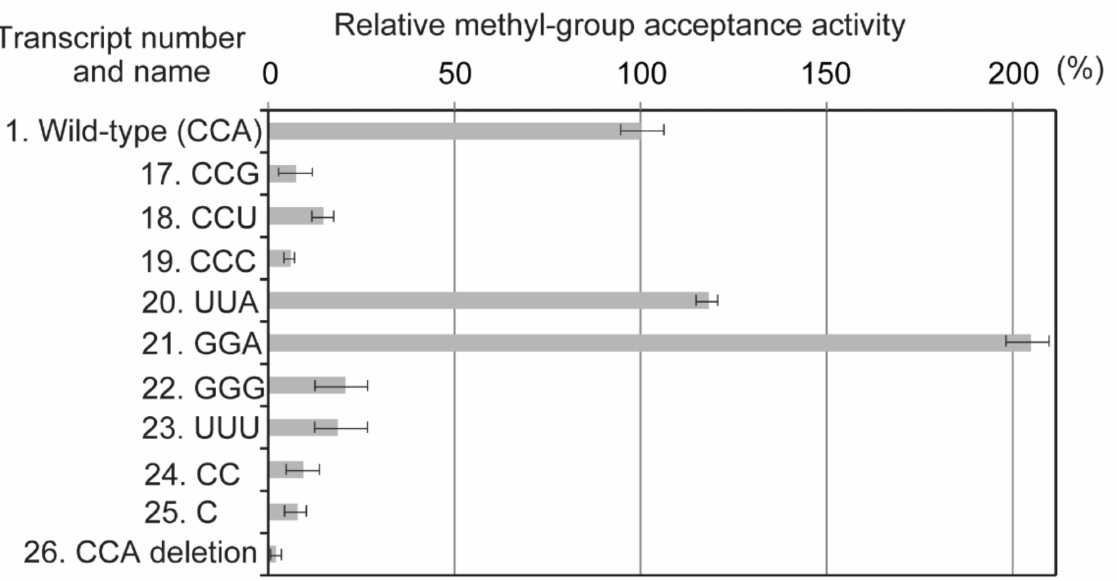
Figure 5. The CCA terminal region is essential for methylation by Trm11-Trm112. The CCA sequence of the wild-type tRNA Phe transcript was substituted by other sequences. For example, transcript 17 possesses CCG instead of CCA. Transcripts 24, 25 and 26 are the deletion mutants of the CCA sequence. The initial velocity of methyl-transfer reaction towards the wild-type tRNA Phe transcript is expressed as 100%. The data in this figure are averages of results from six independent